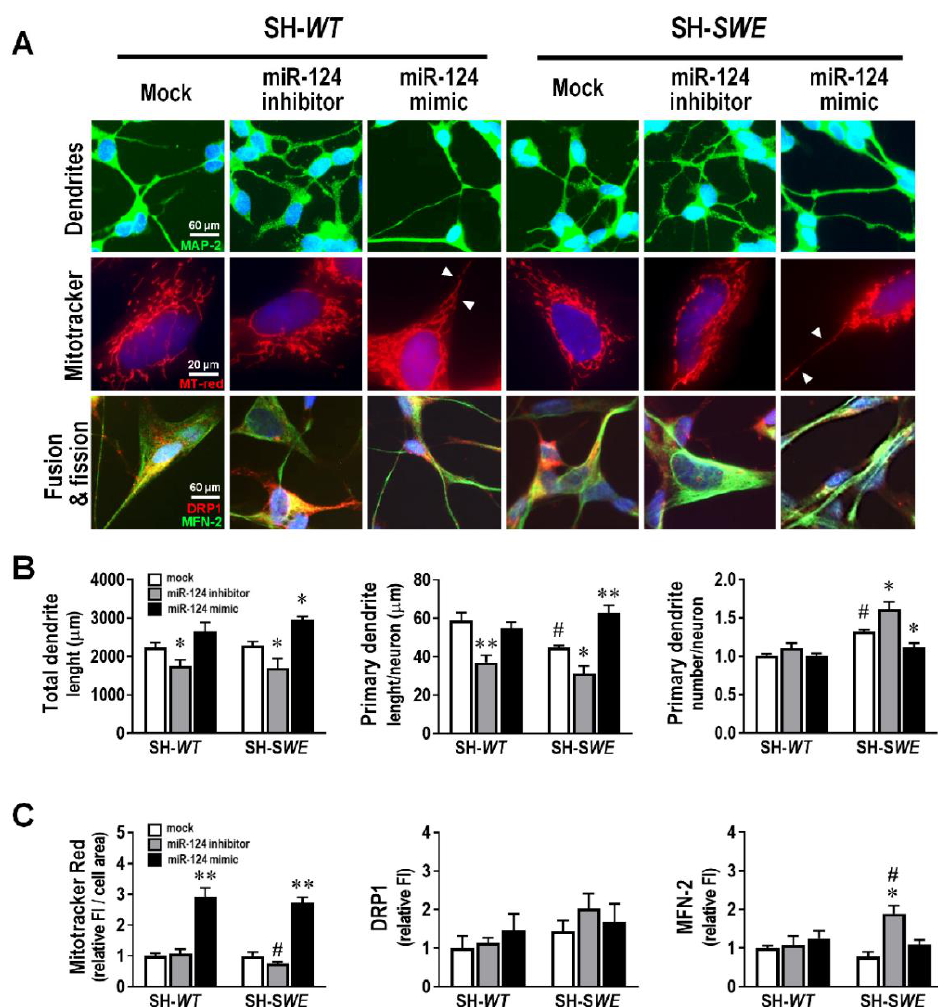
Figure 3. Changes in dendrite outgrowth, mitochondria activation and fusion/fission dynamics by modulation of miR-124 with inhibitor and mimic, relatively to mock, in SH -WT and SH- SWE cells. Cells were obtained, differentiated, and transfected, as detailed in Material and Methods. ( A ) Representative fluorescence images of MAP-2 (green) for dendrites, Mitotracker (red) for mitochondria, and MFN-2 (green)/DRP-1 (red) for fusion/fission mitochondria dynamics. Cell nuclei are stained with Hoechst 33,258 dye (blue). Mitochondrial clumps are seen in the neurites (white arrowheads). ( B ) Evaluation of total dendrite length, primary dendrite length and primary dendrite number. ( C ) Quantification of fluorescence intensities for Mitotracker Red, DRP-1 and MFN-2. Results are mean ± SEM fold change, from at least three independent experiments. * p < 0.05 and ** p < 0.01 vs. respective mock controls, one-way ANOVA with Bonferroni post-hoc test. # p < 0.05, between the same treatment in SH -WT and SH -SWE cells, two-tailed student’s t -test. miR, miRNA; SH- WT , human SH-SY5Y wild-type neurons; SH- SWE , human SH-SY5Y expressing the APP695 Swedish mutant protein; iNEU- WT , iNeurons derived from induced pluripotent stem cells (iPSCs) generated from a healthy control; iNEU- PSEN , iNeurons from iPSCs generated from a patient carrying the PSEN1 ∆ E9 mutation; MAP-2, microtubule-associated protein 2; DRP1, protein dynamin-related protein 1; MFN-2, mitofusin-2 protein; FI, fluorescence